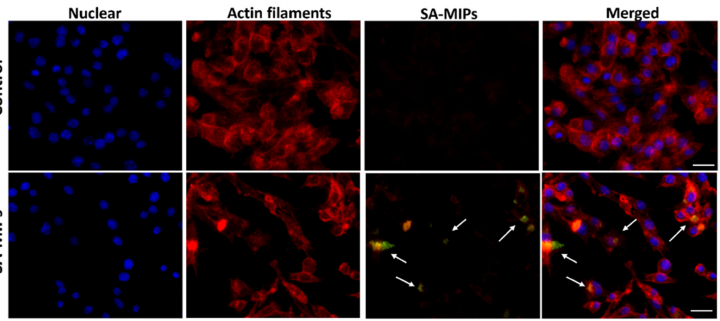
Figure 2. Fluorescence microscopy images of the SA-MIPs’ potential intracellular location in RAW 264.7 cells. Prior to fixation, the cells were incubated for 24 h with culture medium (control) or 100 µ g/mL SA-MIPs. Cells were stained for nuclei (DAPI, blue), actin filaments (rhodamine- phalloidin, red) and SA-MIPs (NBD, green). Scale bar at 10 µ m. Arrows mark binding or inter- nalization of SA-MIP. One representative experiment out of at least three independent experiments is shown.